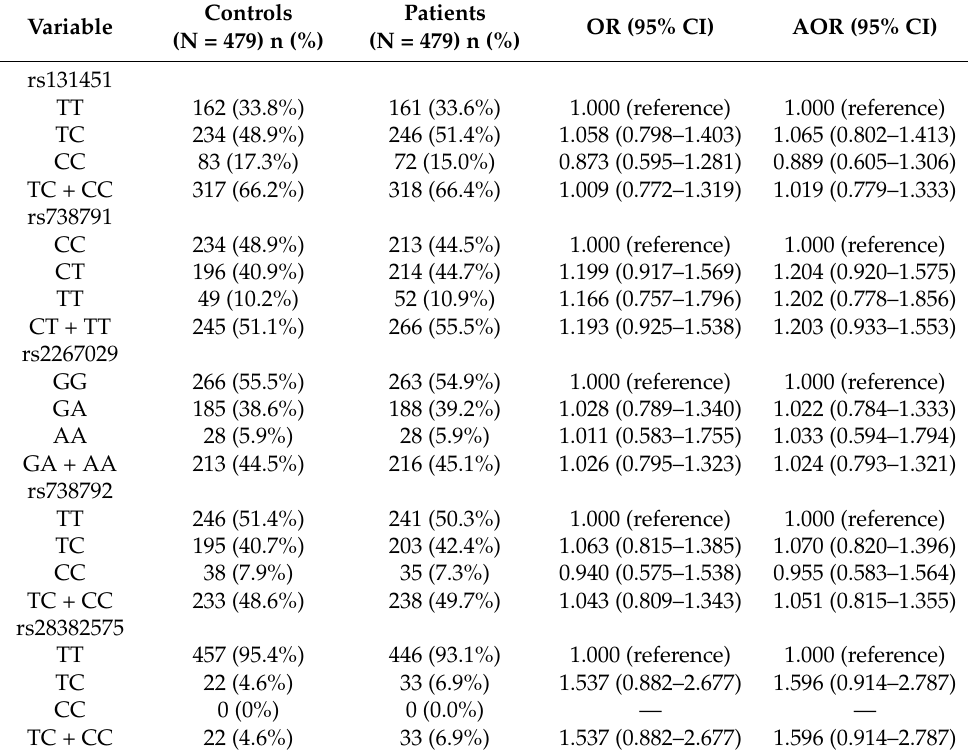
Table 2. Genotype distributions of MMP-11 gene polymorphisms in 479 controls and 479 patients with